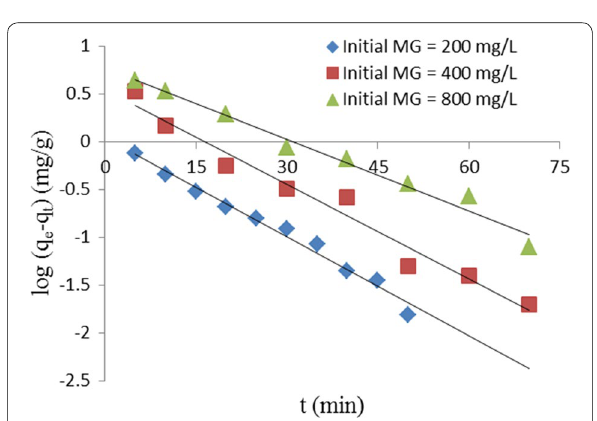
Fig. 7 Pseudo-first order kinetic plot for removal of MG by